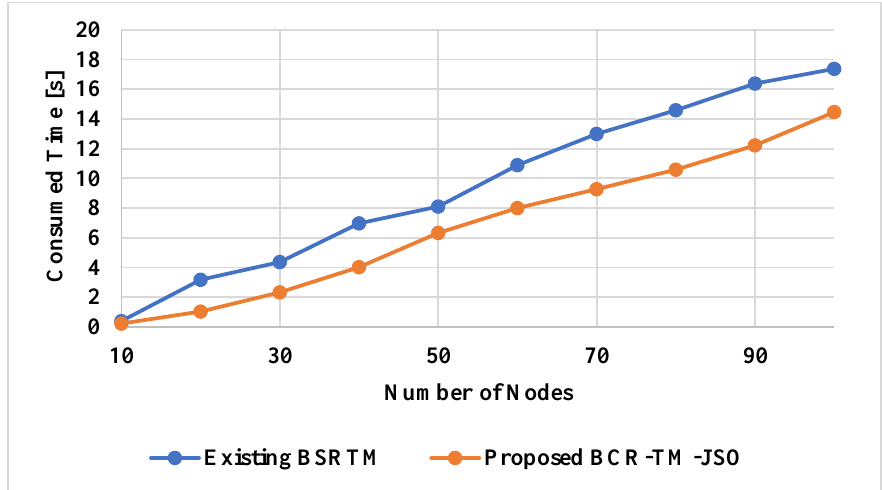
Figure 10. Performance of consumed time with existing BSRTM [21].